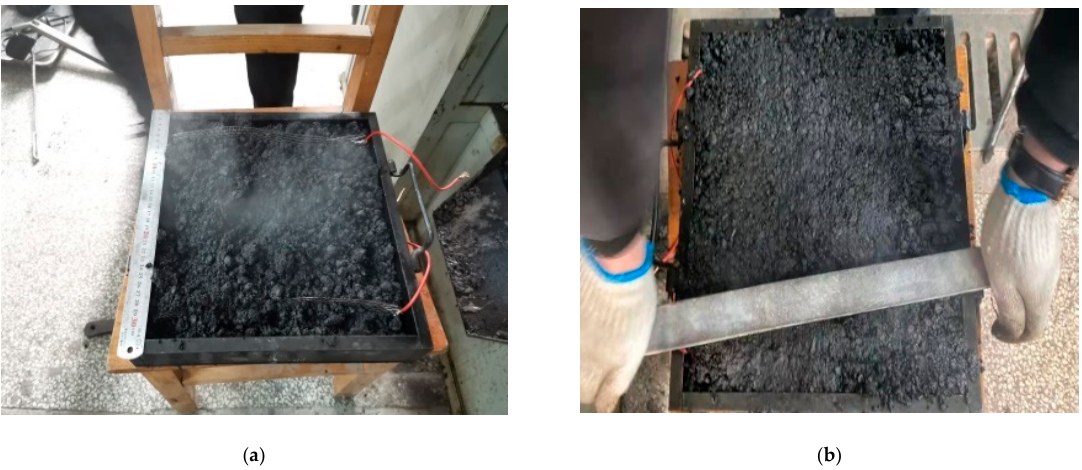
Figure 7. Left and right mesh and straight electrode layout. ( a ) mixture paving; ( b ) Surface smoothing.